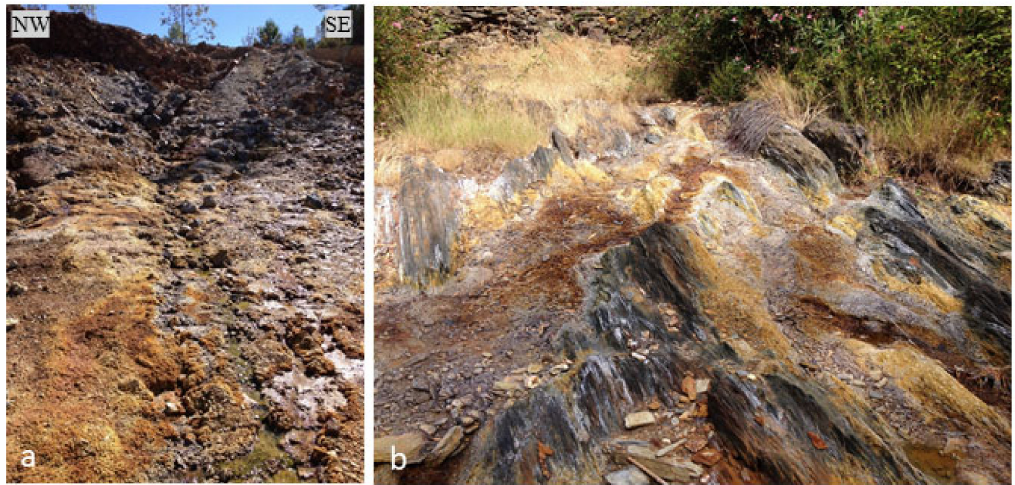
Figure 17. Occurrence of gypsum blankets in different springs like around the entrance of RHS Anabel’s garden ( a ), and in the New Gypsum spring ( b ) rising from a shale bed (Culm materials) showing extensive gypsum deposits with